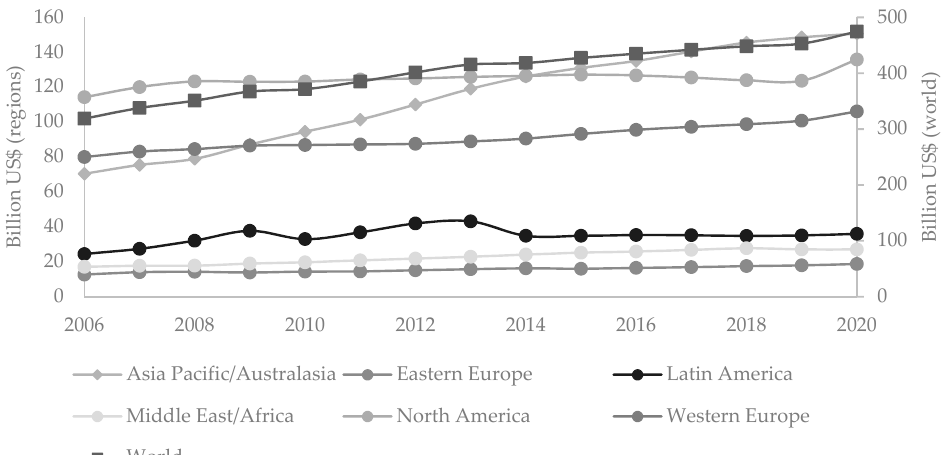
Figure 1. The retail value of health and wellness packaged food by region, 2006–2020. Source: Author’s compilation using data from [23].